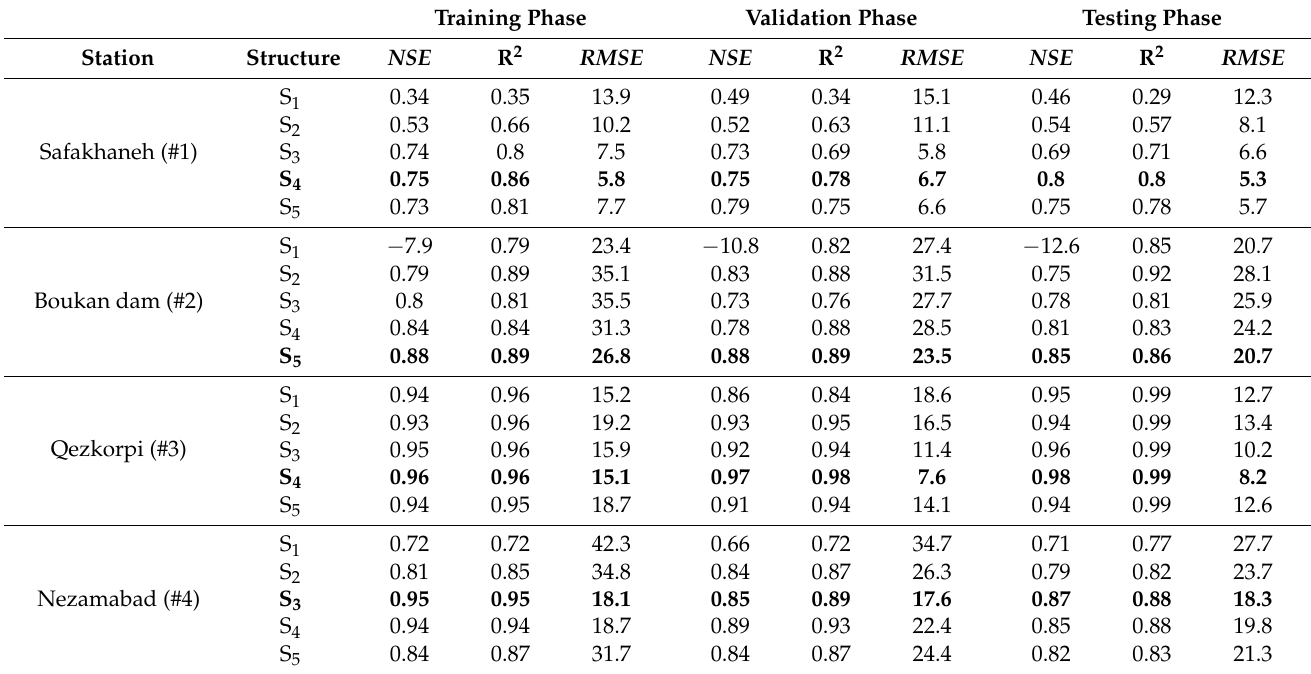
Table 2. Performance of GRU-based streamflow forecasting models for five station structures in the Zarrineh River basin with varying monthly lag